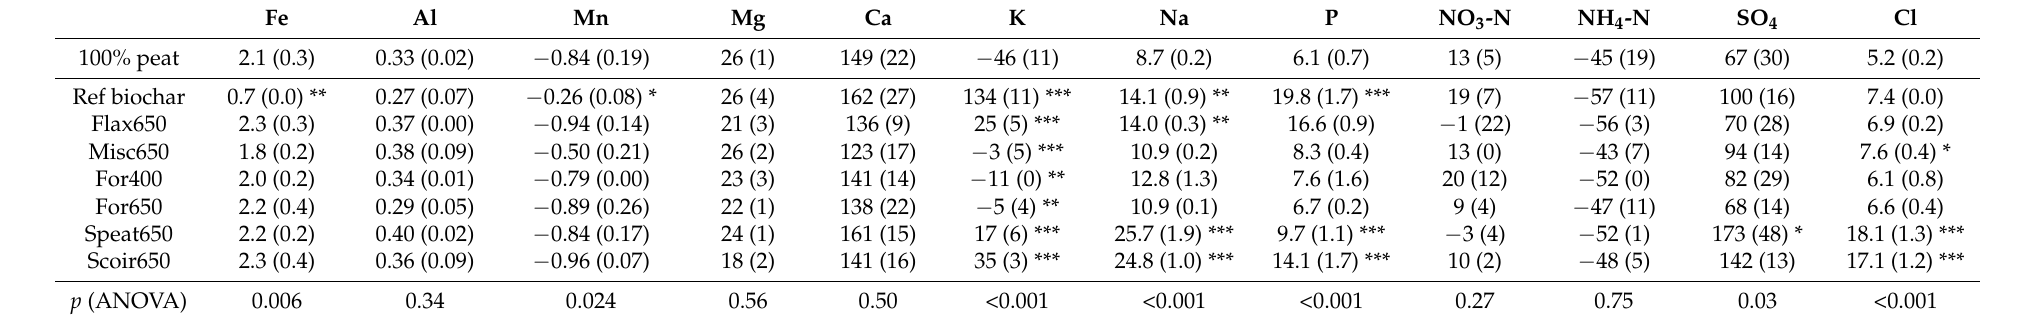
Table 3. Net leached mass (in mg) of the elements in the leaching experiment as calculated by Equation (1) (average of two replicates with standard deviation in parentheses). Numbers are compared by ANOVA, and for the treatments with biochar compared with control treatment of pure limed peat by Dunnett (*: p < 0.05; **: p < 0.01; ***: p < 0.001). Codes of the biochars: See Table 1. Ref biochar: Reference biochar based on stone oak